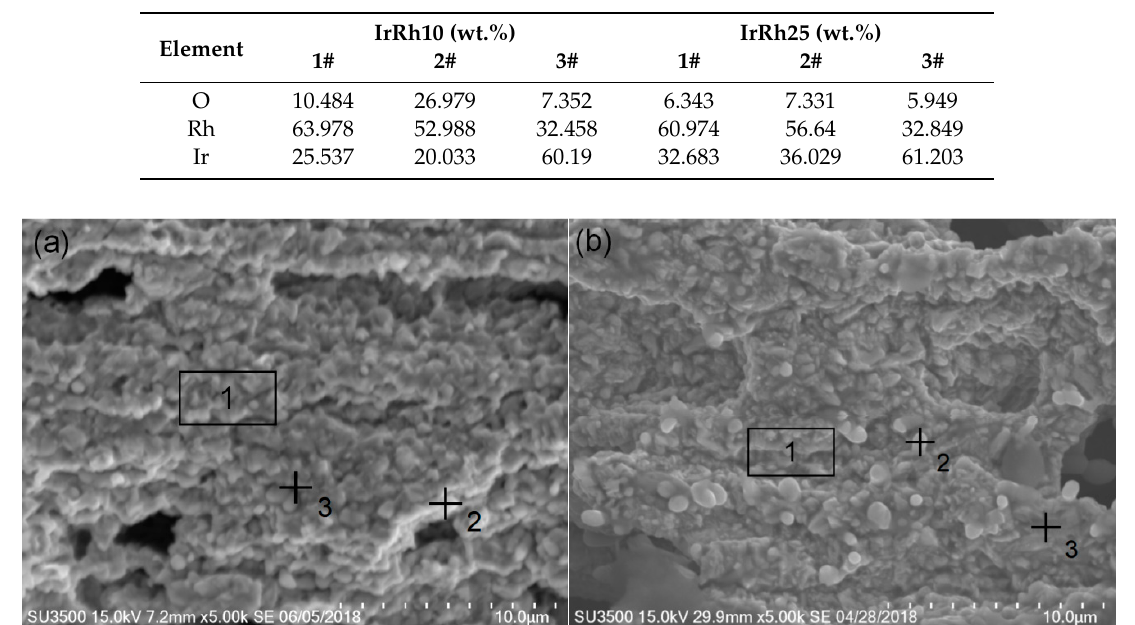
Figure 5. The “ridge” surface morphology of IrRh25. Table 4. Surface mass fraction of alloys after oxidation.